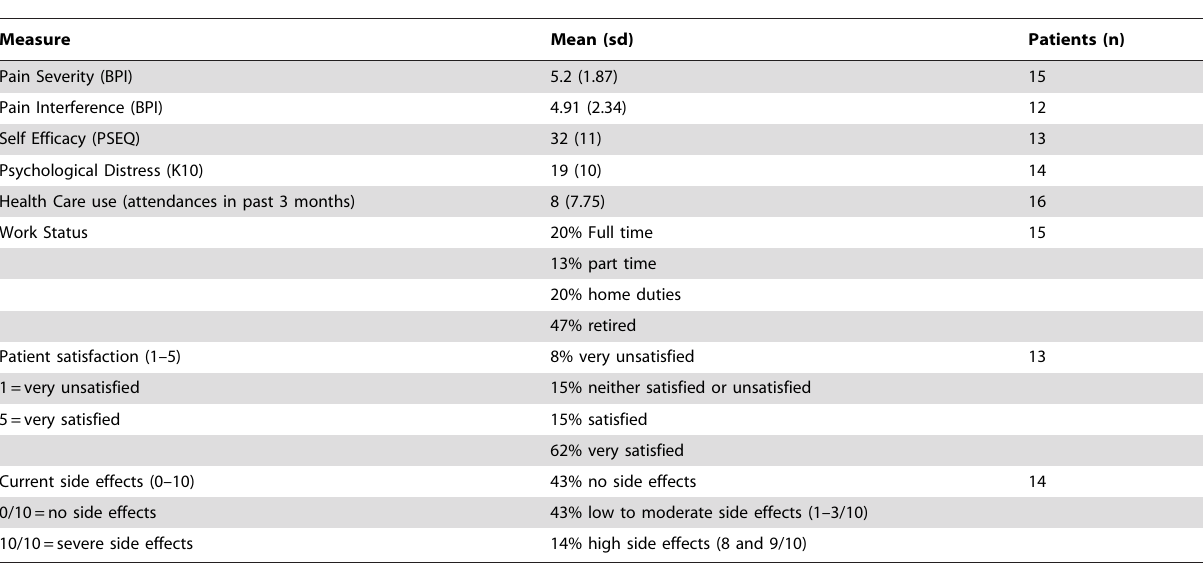
Table 1. Standard measures data post cessation of IT therapy.